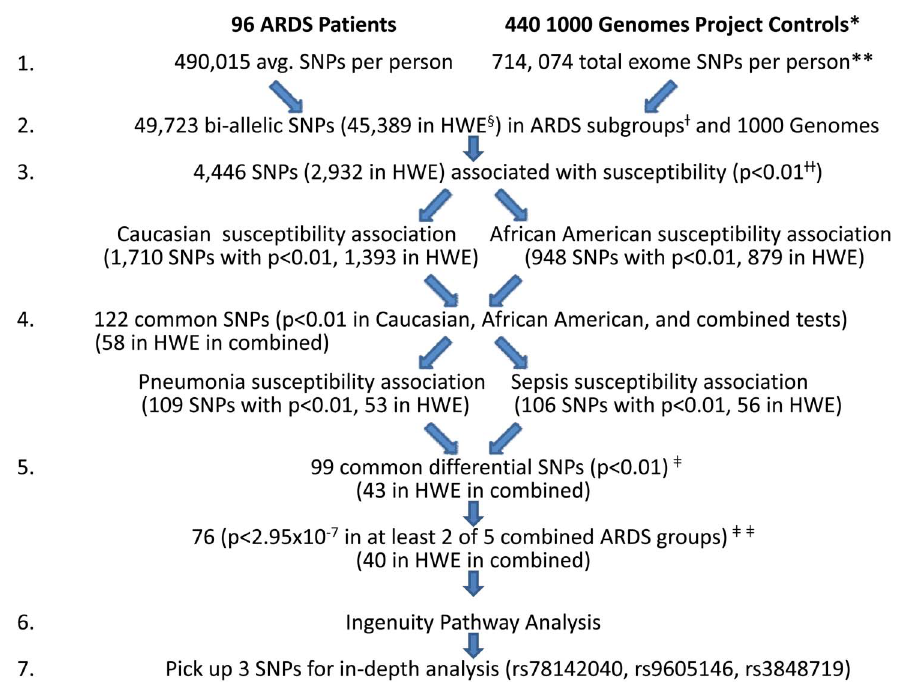
Figure 1. Pipeline of the exome-seq data analysis workflow. After processing the data using the GATK pipeline, this filtering workflow was derived to identify SNPs which were associated with measures of susceptibility across the racial and etiology groups of cases. SNPs were filtered based on strength of association, coding effect, and functional prediction prior to testing for association with other ARDS phenotypes. *, The sample contains African American and Caucasian patients, so the EUR and ASW healthy controls from 1000 Genomes were used for comparison; **, In the 1000 Genomes Project exome sequence, the same 714,074 SNPs are present for all 440 EUR and ASW; 1 , HWE=Hardy Weinberg Equilibrium, p . 0.0001; + , African American with pneumonia, African American with sepsis, Caucasian with pneumonia, Caucasian with sepsis; + + , x 2 test of ARDS vs. respective 1000 Genomes Project control groups; ` , SNPs with P-value , 0.01 in the overall comparison, Caucasian ARDS comparison, and African American comparison with 1000 Genomes were filtered further by p , 0.01 in the sepsis comparison and pneumonia comparison; ` ` , All ARDS cases, all pneumonia cases, all sepsis cases, all African American cases, all Caucasian cases. doi:10.1371/journal.pone.0111953.g001 PLOS ONE |